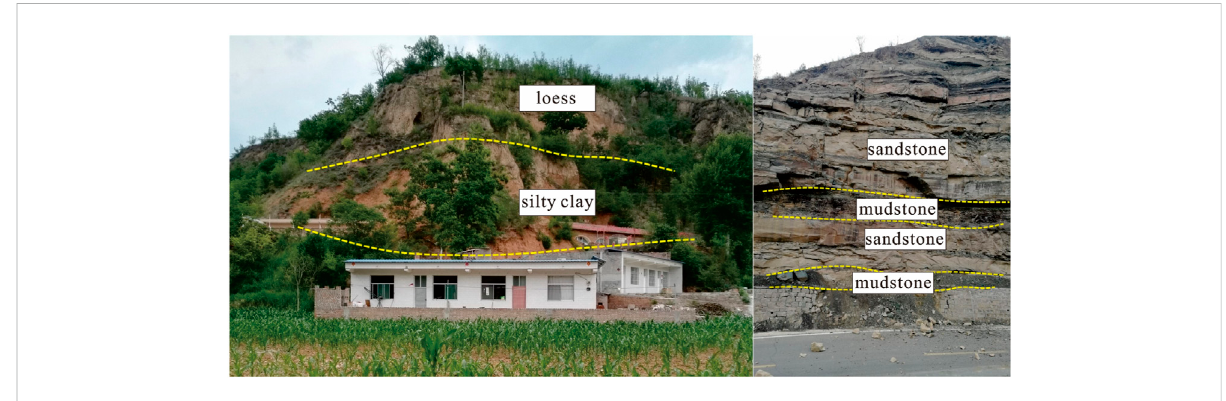
FIGURE 2 Typical vertical distribution of soil and lithology in the study